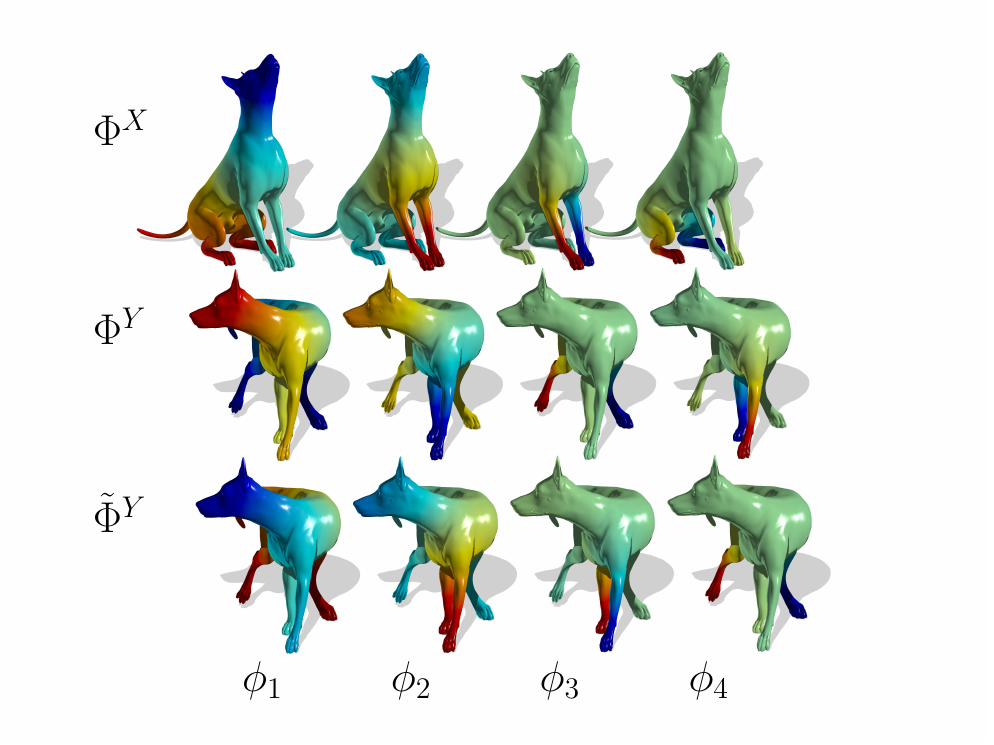
Figure 2. Feature point correspondence of two nearly isometric shapes of a